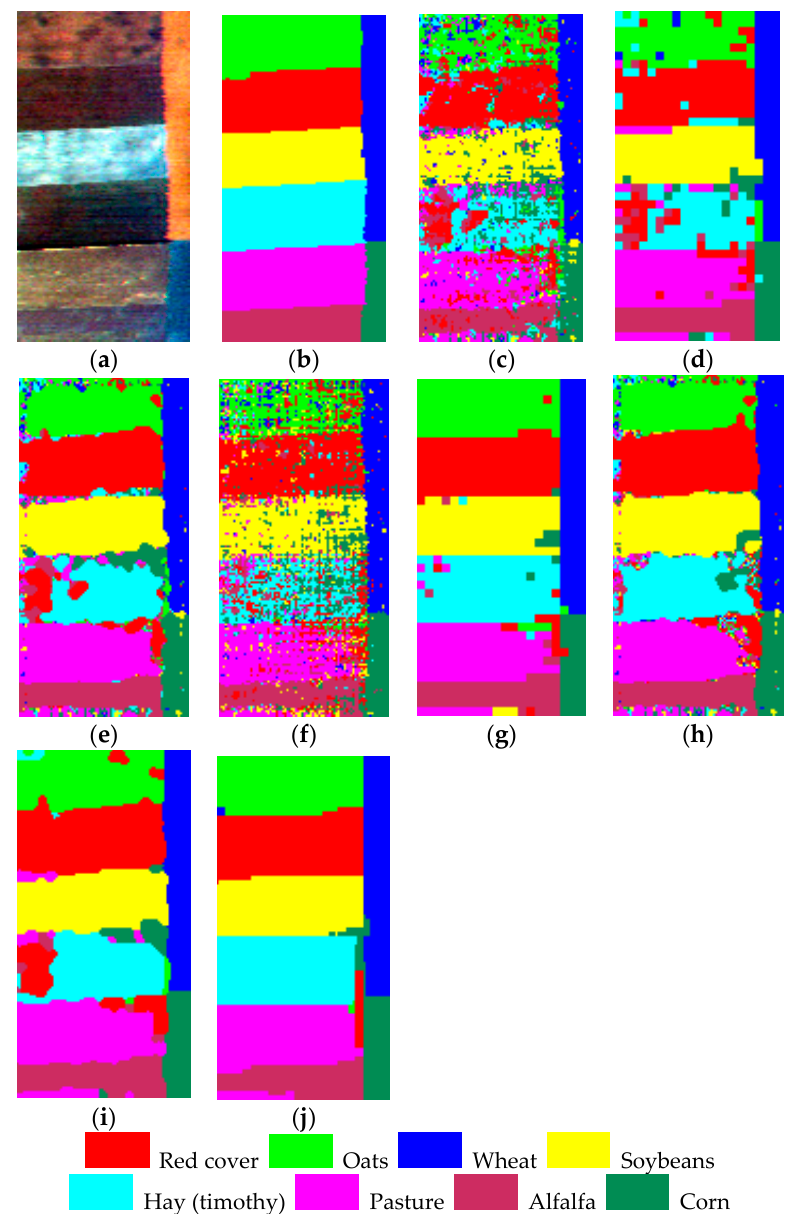
Figure 4. Sub-pixel mapping results for the synthetic dataset (FLC1): ( a ) original high-resolution remotely sensed imagery; ( b ) reference classification map obtained by eCognition software; ( c ) sub-pixel mapping result obtained using FCLS+AM, ( d ) FCLS+HC, ( e ) FCLS+HNN, ( f ) SUnSAL-TV+AM, ( g ) SUnSAL-TV+HC, ( h ) SUnSAL-TV+HNN, ( i ) MRF, ( j ) JSSM.